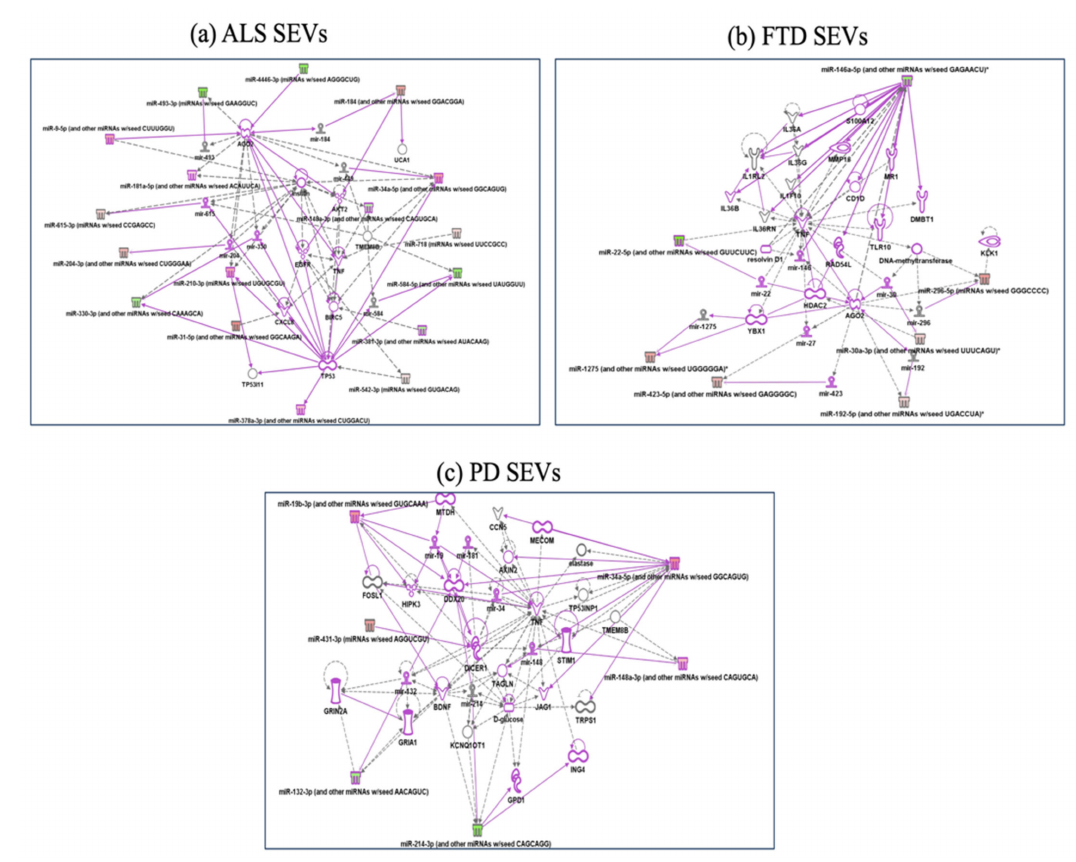
Figure 4. IPA networks among deregulated miRNAs in SEVs from ALS ( a ), FTD ( b ), PD ( c ). For ALS miRNAs involvement in regulation of DDX58/IFIH1, through miR31-5p and miR615-5p ( a ); for FTD IL1F10 and TLR10 regulation by miR146a-5p ( b ); for PD, regulation of GRIA1, Glutamate receptors, by miR-132-3p, involvement of JAG1 and TNF regulated by miR-34 ( c ). Pink color indicates activation while green color indicate suppression. No pathway could be calculated for AD disease for the few miRNAs targets. FTD = Fronto-Temporal Dementia; ALS = Amyotrophic Lateral Sclerosis; PD = Parkinson Disease; CTRs = controls; SEVs = small extracellular